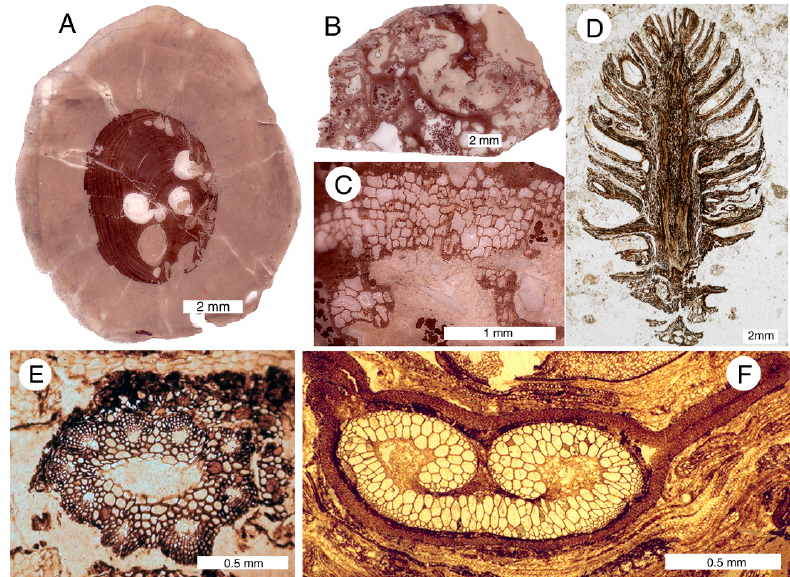
Figure 6. Woods permineralized with calcite. ( A – C ) acetate peels of teredo-bored wood in a calcareous concretion, Lower Cretaceous, Apple Bay, Vancouver Island, BC, Canada; ( D ) Longitudinal section of apical region of ovulate cone of Hubbardiastrobus cunninghamiodes from Apple Bay [13] (photo courtesy of Brian A. Atkinson; ( E ) Calamites stem in Pennsylvanian coal ball, Lancashire coal field, England. Photo courtesy of Hans Steur; ( F ) Anacheropteris involuta preserved in Upper Pennsylvanian coal ball, IL, USA. Photo courtesy of University of M ū nster Paleobotany Research Center.